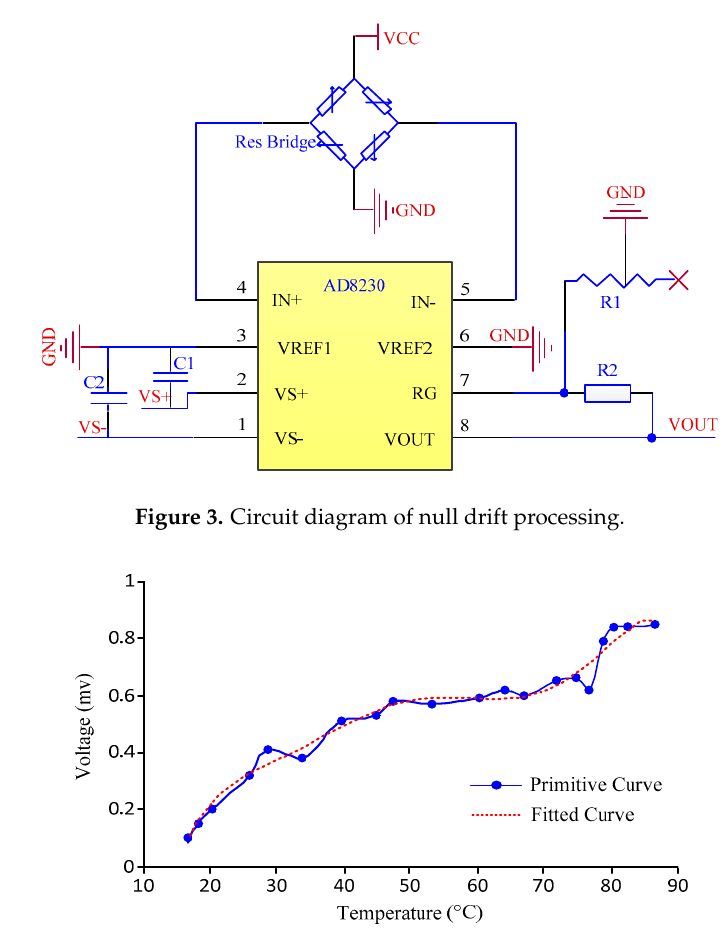
Figure 4. Calibration fitting curve of temperature drift.